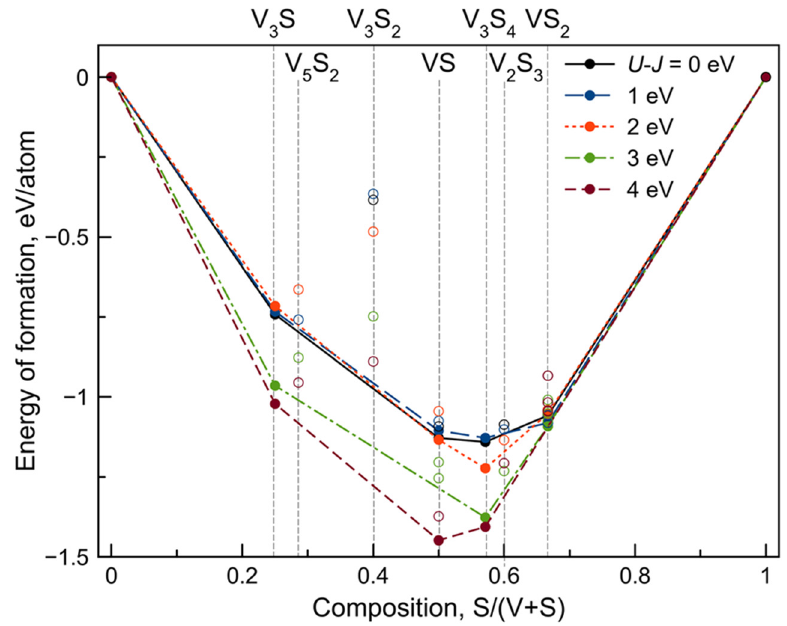
Figure 1. Calculated convex hulls of the V–S system with different U eff values.